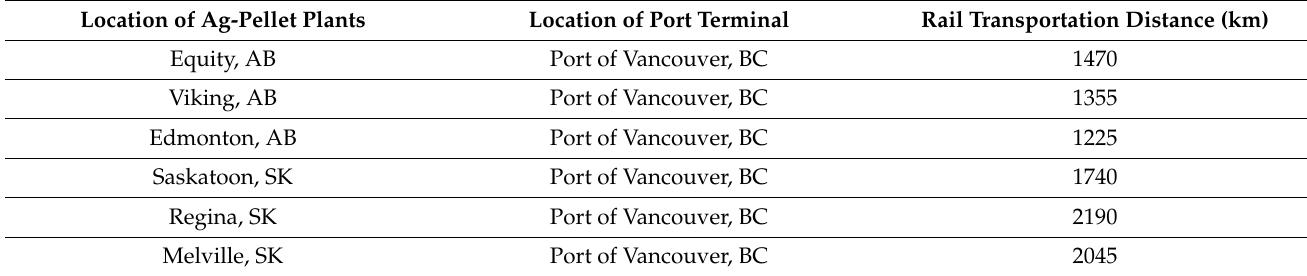
Table 2. Rail transportation distance between the ag-pellet plants and the Port of Vancouver, British Columbia (BC) (Personal communications with Canadian National Railway, December 2020).